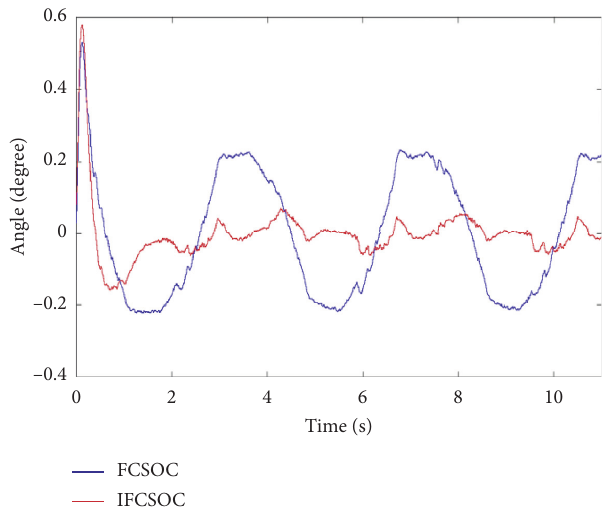
Figure 10: Diagram of sinusoidal tracking error